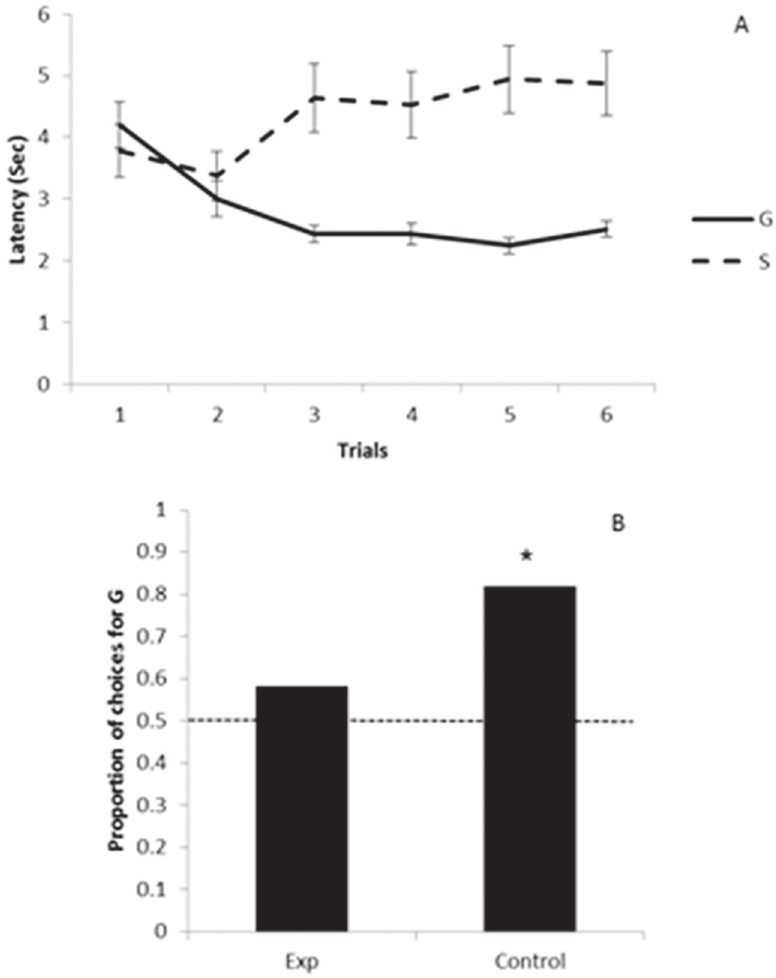
Fig 5. (A) Study 3: Mean latency as a function of trials with the generous and selfish experimenters. The dashed line represents the latency to approach the selfish (S) experimenter, whereas the full line represents the latency to approach the generous (G) experimenter. ISI: inter-session interval. Error bars denote ± 1 sem. (B) Study 3: Proportion of choices for the generous (G) over the selfish (S) experimenter. The horizontal dashed line indicates the 0.50 chance level. * : p <